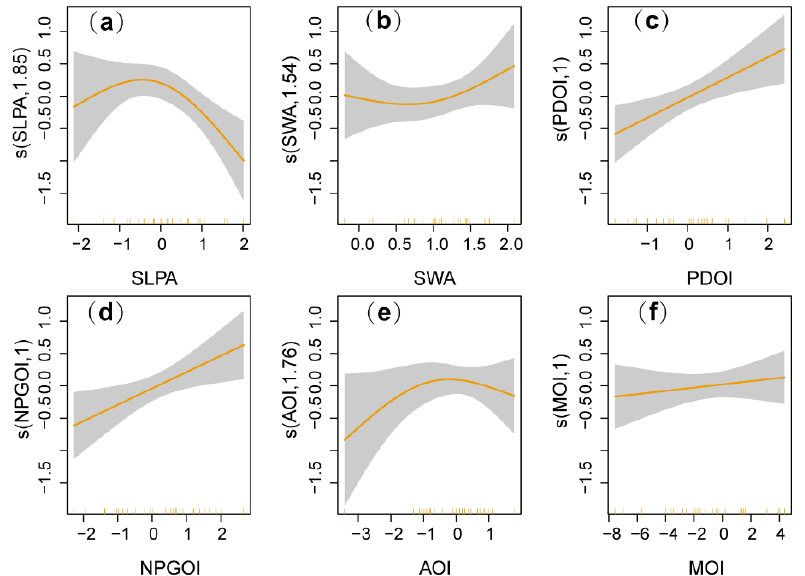
Figure 7. Generalized additive models (GAMs) between anchovy catch and environmental variables and climate indices in China. ( a ) Anchovy versus Sea Level Pressure Anomaly (SLPA). ( b ) Anchovy versus Scalar Wind Anomaly (SWA). ( c ) Anchovy versus Pacific Decadal Oscillation index (PDOI). ( d ) Anchovy versus North Pacific Gyre Oscillation index (NPGOI). ( e ) Anchovy versus Arctic Oscillation index (AOI). ( f ) Anchovy versus Monsoon Oscillation index (MOI). Tick marks on the x -axis represent observed data points. Y -axis represents the smooth fitted function of the dependent values and is centered to zero. The values in parentheses in the y -axis label indicate the degree of freedom of the model.